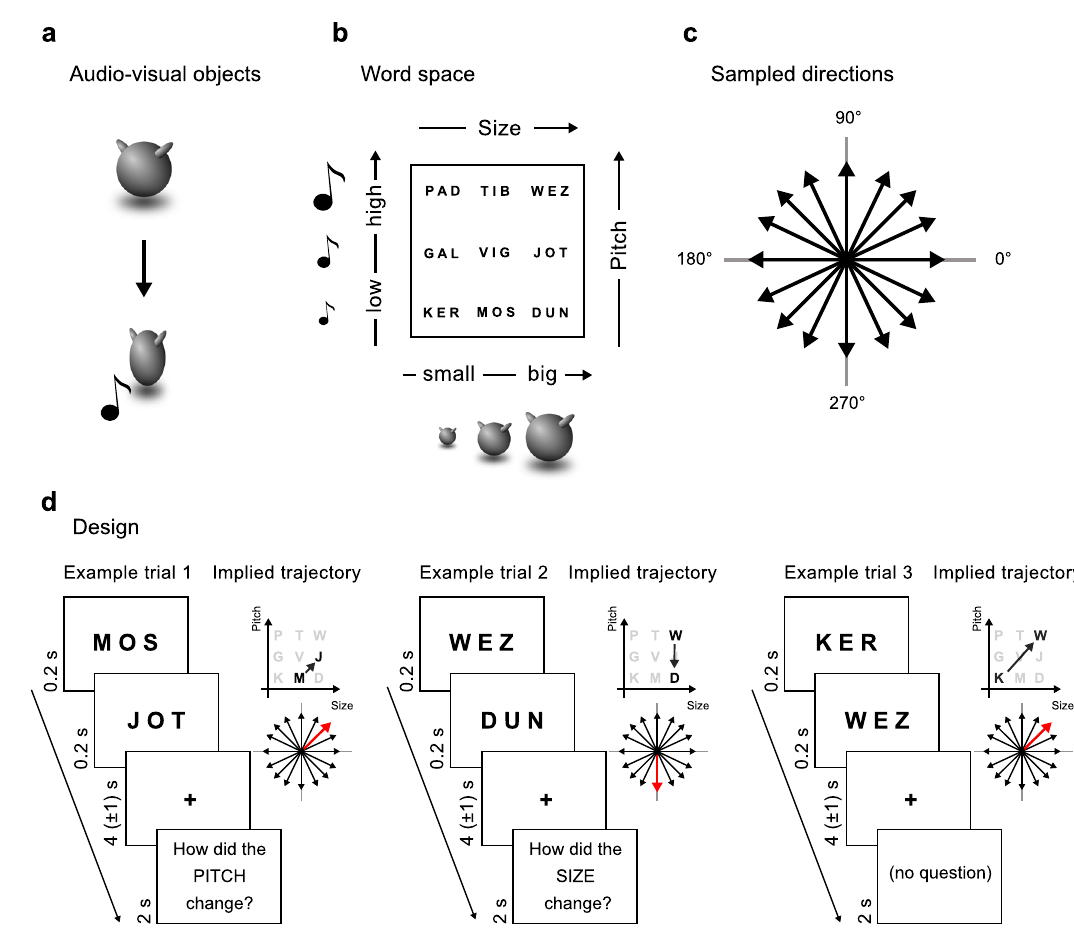
Fig. 1 Experimental design. a Example of an audiovisual object, producing a sound during a squeezing animation. b Nine audiovisual objects, resulting from the unique combination of size and sound, are labelled with abstract names that participants learn during the course of a behavioural training. c In our bidimensional conceptual space, there are 16 possible directions between two words. d Examples of trials during the comparison task. For each trial, two words are presented in rapid sequence, and participants are instructed to think about how both the perceptual features implied by the object names changed. This was conceivable as a linear trajectory in the bidimensional conceptual